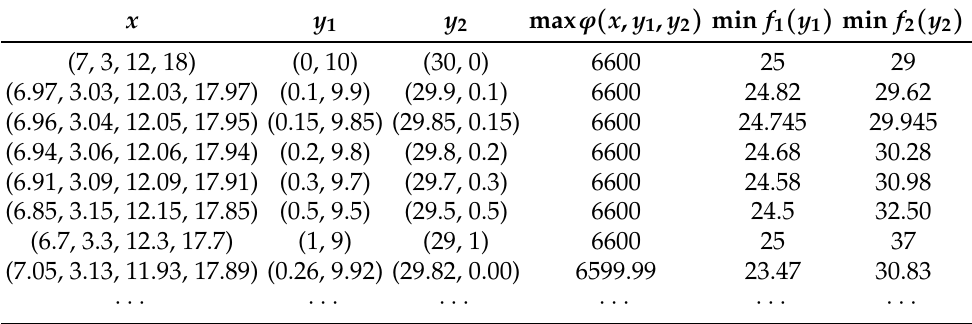
Table 3. The IPSO algorithm for solving the numerical result of Example